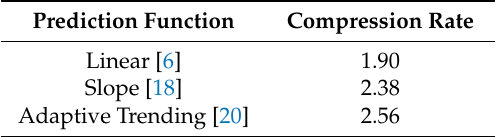
Table 1. Compression rate on ECG signals of previously-proposed prediction